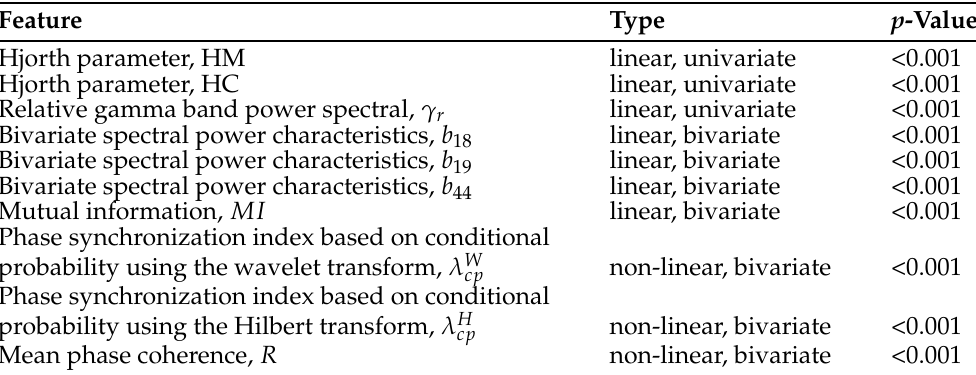
Figure 3. Evaluation of the complexity metrics for each extracted value: ( a ) Fisher discriminant ratio, F1: a high value of F1 shows that the feature is discriminant, ( b ) the volume of the overlap interval, F2: a low value of F2 indicates small amount of overlap among the classes, and ( c ) the individual feature efficiency, F3: a high value of F3 implies a good separability between the classes. The horizontal dotted blue represents the threshold values. Table 2. Retained attributes from the feature complexity analysis, their types, and the corresponding p -value of the t